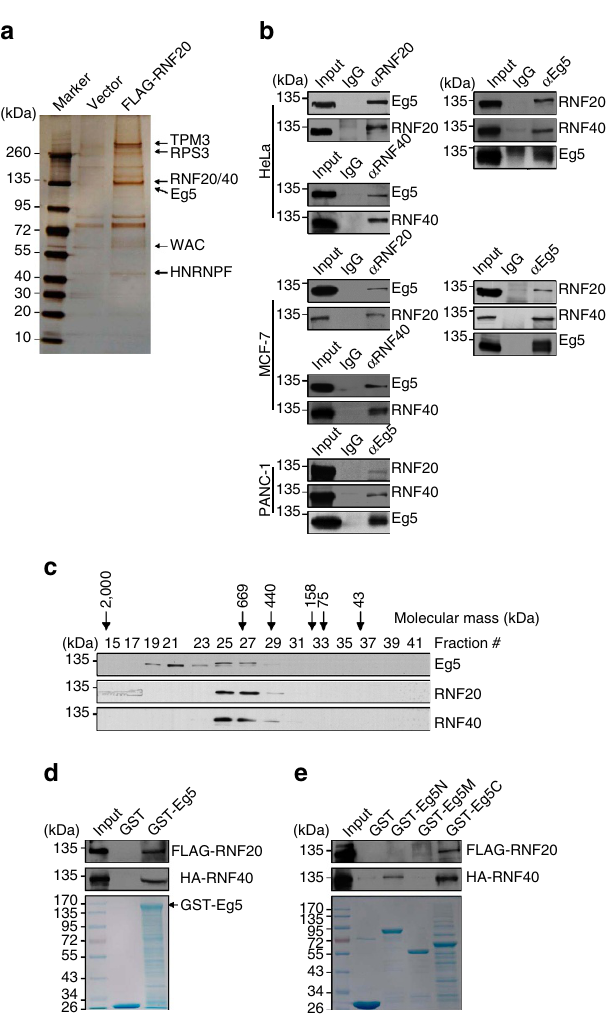
Figure 1 | Ubiquitin ligase RNF20/40 interacts with the motor protein Eg5. ( a ) Immunoaffinity purification of RNF20-containing protein complexes. Cellular extracts from HeLa cells stably expressing FLAG (vector) or FLAG-RNF20 were immunopurified with anti-FLAG affinity columns and eluted with FLAG peptides. The eluates were resolved by SDS–PAGE and silver-stained. The protein bands were retrieved and analysed by mass spectrometry. ( b ) The RNF20/40 complex interacts with Eg5 in vivo . Immunoprecipitation assays were performed with antibodies against the indicated proteins followed by immunoblotting in HeLa, MCF-7, and PANC-1 cells. ( c ) Co-fractionation of Eg5 and the RNF20/40 complex by fast protein liquid chromatography. Cellular extracts from MCF-7 cells were fractionated on Superose 6 size exclusion column. The chromatographic profile with the elution positions of calibrating proteins of known molecular mass is shown. The chromatographic fractions were analysed by western blotting with antibodies against indicated proteins. ( d ) Eg5 interacts directly with RNF20 and RNF40 in vitro . GST pull-down assays were performed with GST-Eg5 and in vitro transcribed/translated RNF20 and RNF40. ( e ) Identification of the domains responsible for the direct interaction between Eg5 and RNF20 or RNF40. Bacterially purified GST, GST-Eg5N, GST-Eg5M or GST-Eg5C was incubated with in vitro transcribed/translated RNF20 or RNF40, after which GSTpull-down assays were performed.